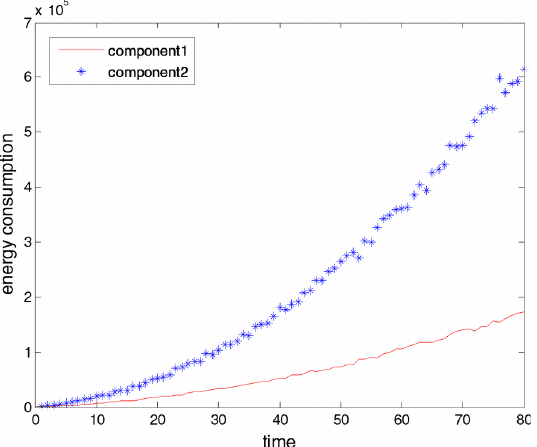
Figure 2. Energy consumption process of